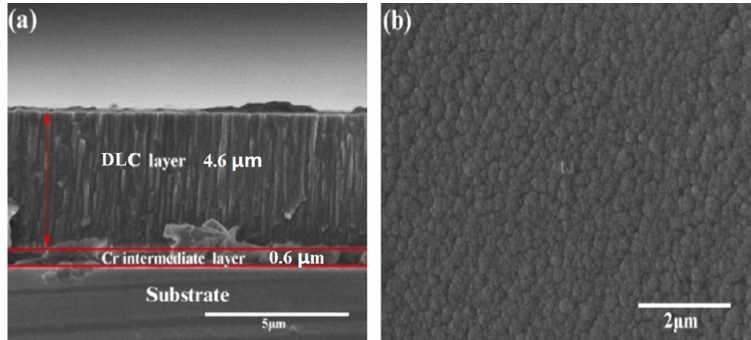
Figure 5. Cross-sectional morphology ( a ) and surface morphology ( b ) of DLC coating.